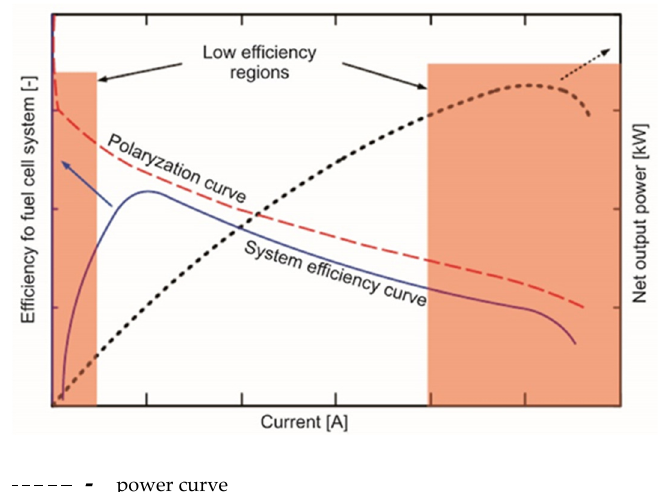
Figure 7. Characteristics of a PEM fuel cell operating in the conditions of the vehicle board [15].